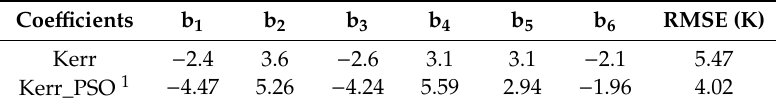
Table 2. Calculation coe ffi cients for Kerr algorithm in this